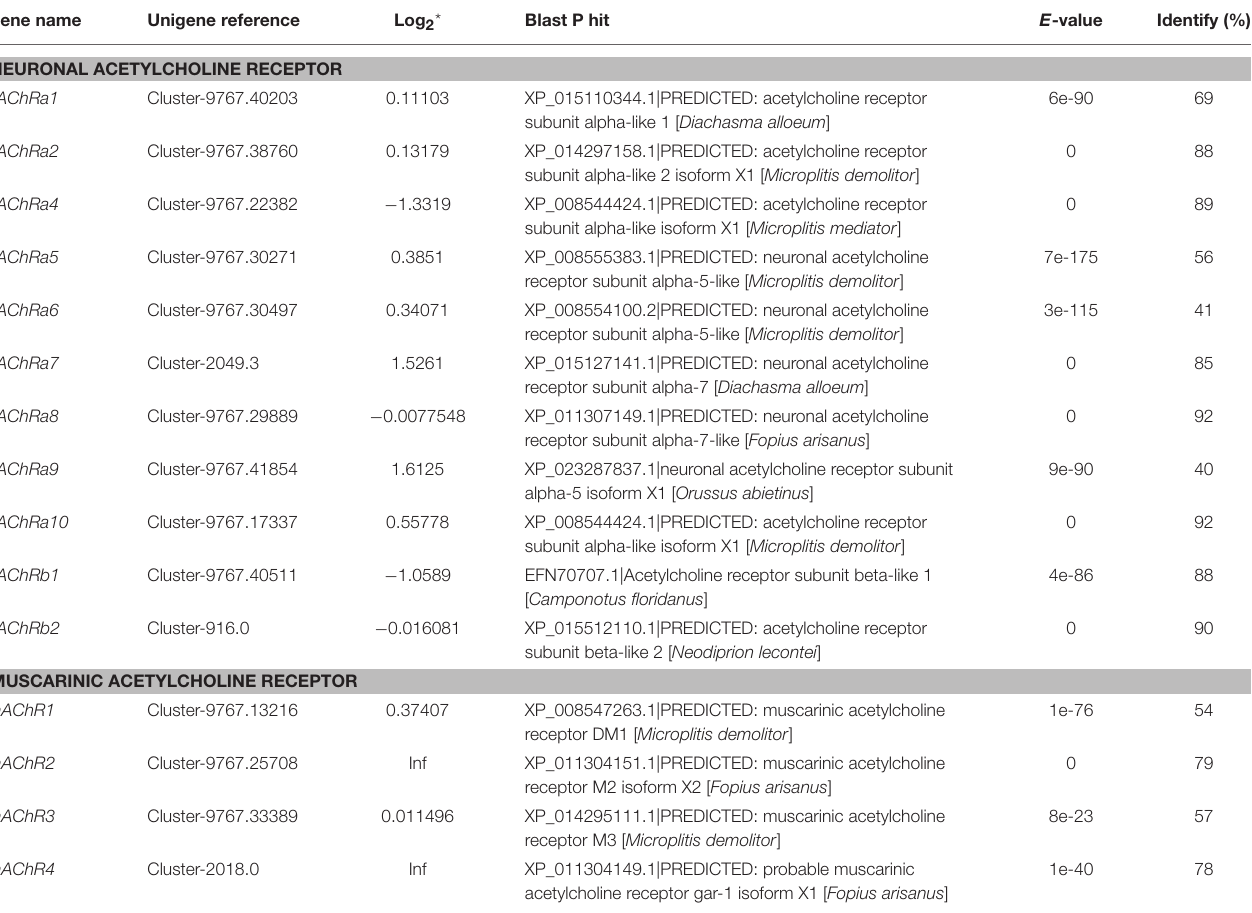
TABLE 3 | The identified acetylcholine receptors in A. gifuensis